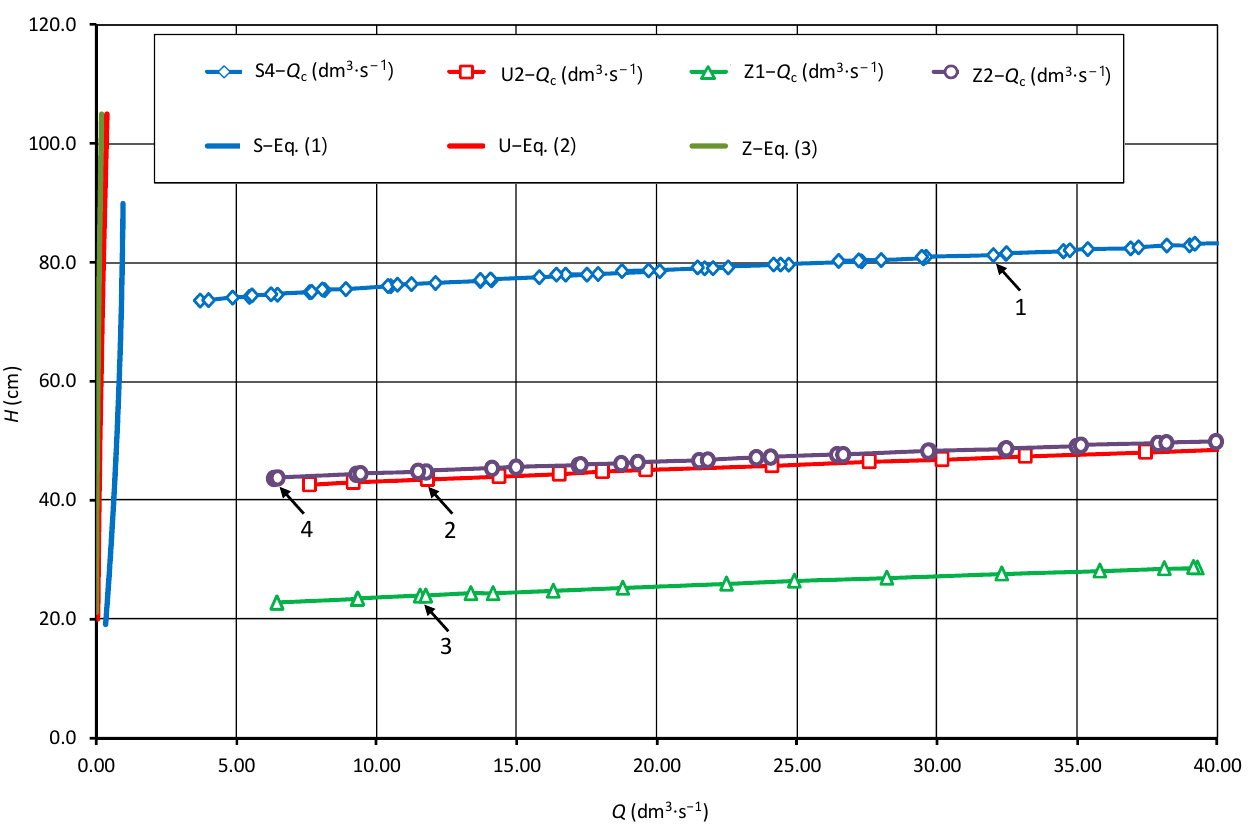
1—variant S4; 2—variant U2; 3—variant Z1; 4—variant Z2.